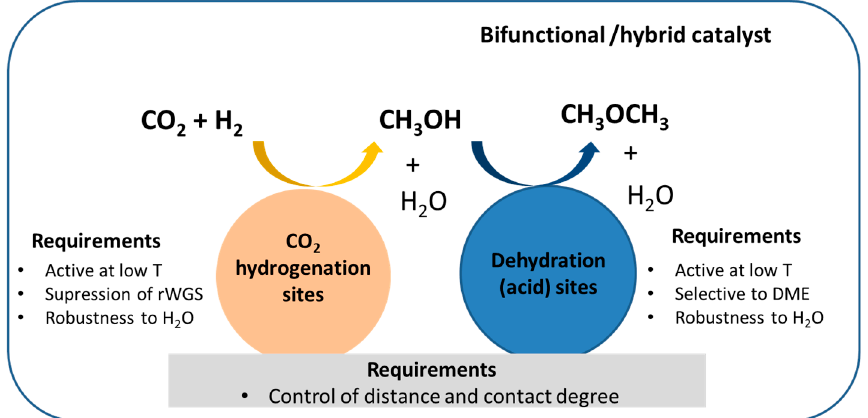
Figure 3. Scheme of bifunctional/hybrid catalysts and requirements for hydrogenation and dehydration functionalities for direct synthesis of DME from CO 2.